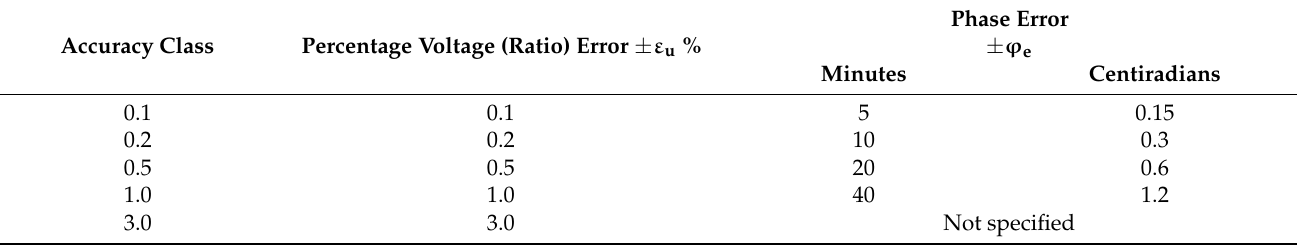
Table 3. Metering class accuracy requirements as per IEC 60044-7 and IEC 61869-11 [18,23,24].